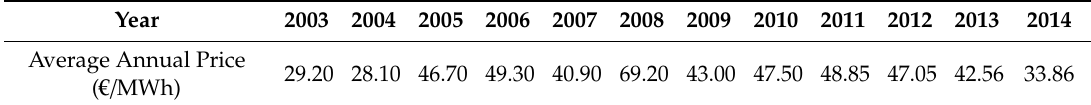
Table 2. Wholesale electricity market price in